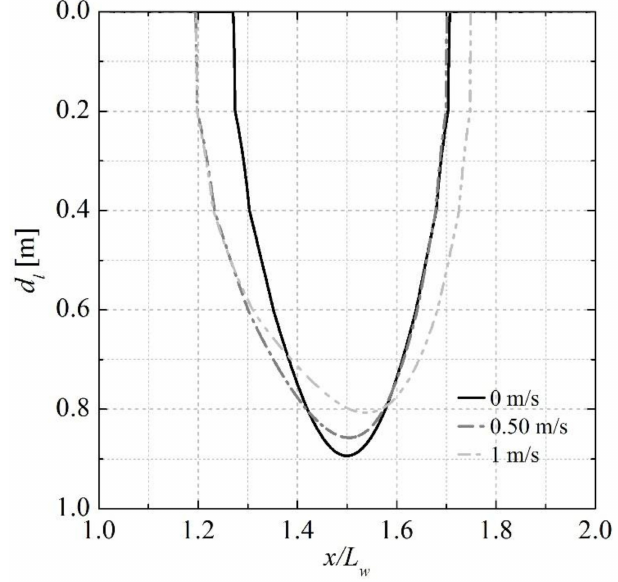
Figure 8. Maximum liquefaction depth with various current velocities.